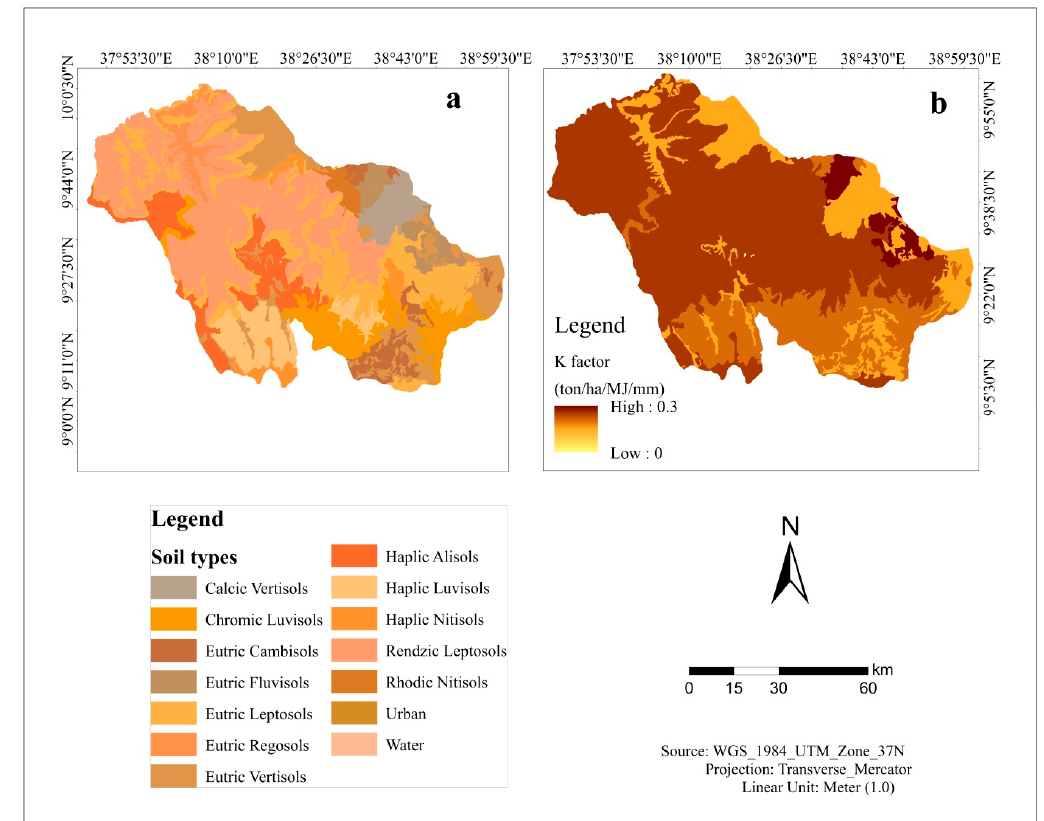
Figure 5. Map of soil types ( a ) and Soil erodibility (K) factor ( b ). Table 3. Soil types, color, coverage and its K-factor.